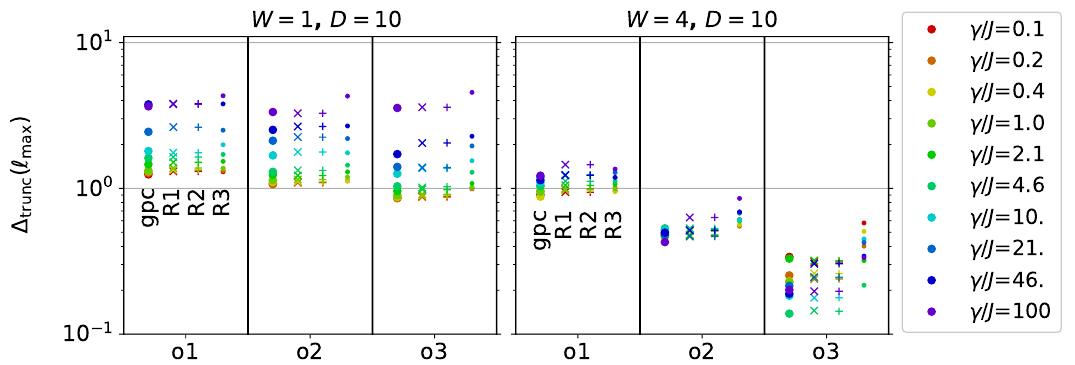
( ℓ ) between exact spectrum of the truncated matrix Figure 11: Deviation ∆ trunc max and the flow equation result for the disordered dissipative scattering model (72), averaged over 100 samples. The truncation order is denoted by (o1,o2,o3) for trun- cation in order